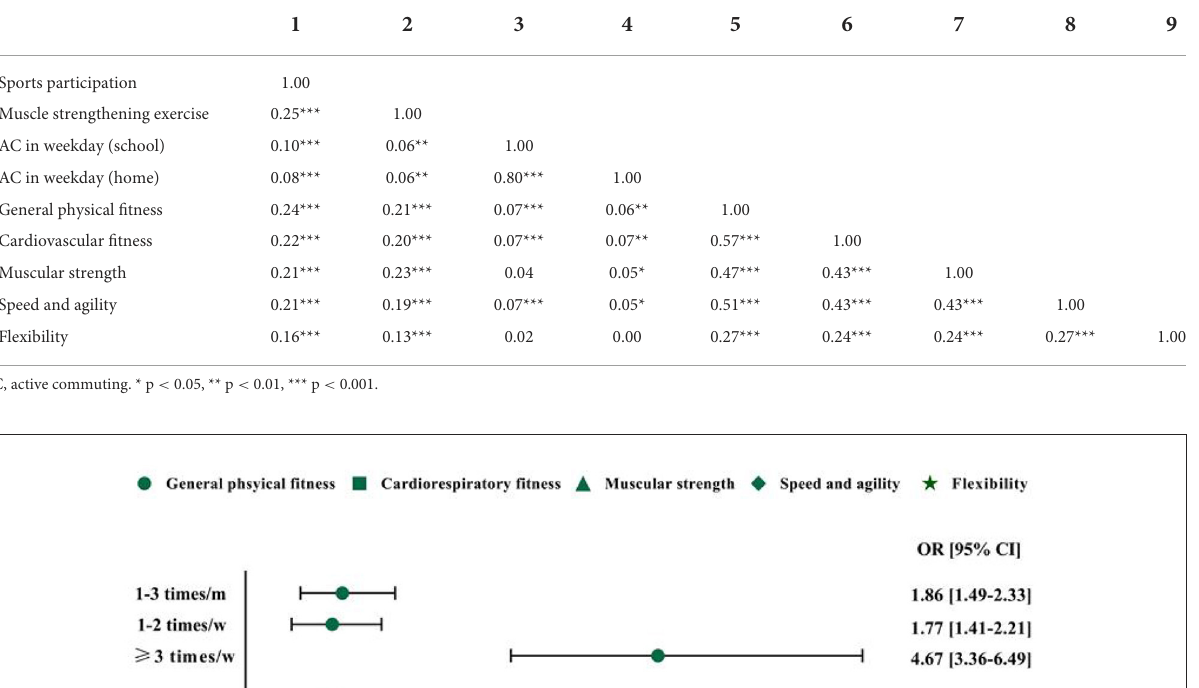
TABLE 2 Partial correlation between sports participation, muscle strengthening exercise, active commuting and self-reported health-related physical fitness.